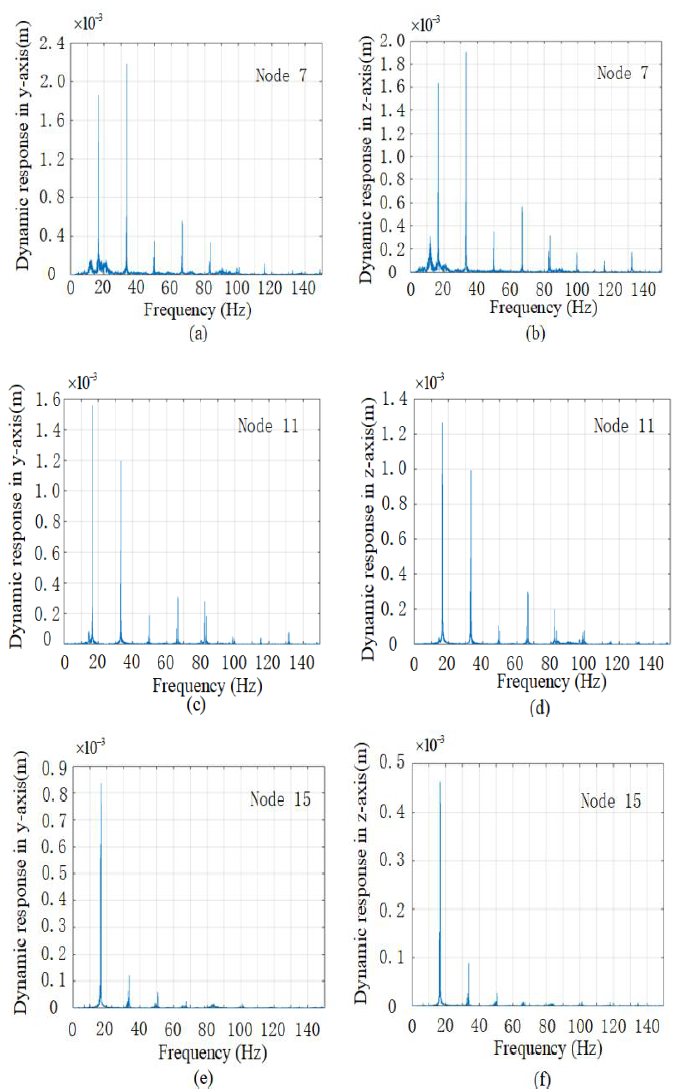
Figure 18. The experimental dynamic response with 0.4 mm parallel misalignment and 0.5 ◦ angular misalignment of nodes 7, 11, and 15 in the y-axis and z-axis. ( a ) Node 7 in the y-axis. ( b ) Node 7 in the z-axis. ( c ) Node 11 in the y-axis. ( d ) Node 11 in the y-axis. ( e ) Node 15 in the y-axis. ( f ) Node 15 in the z-axis.